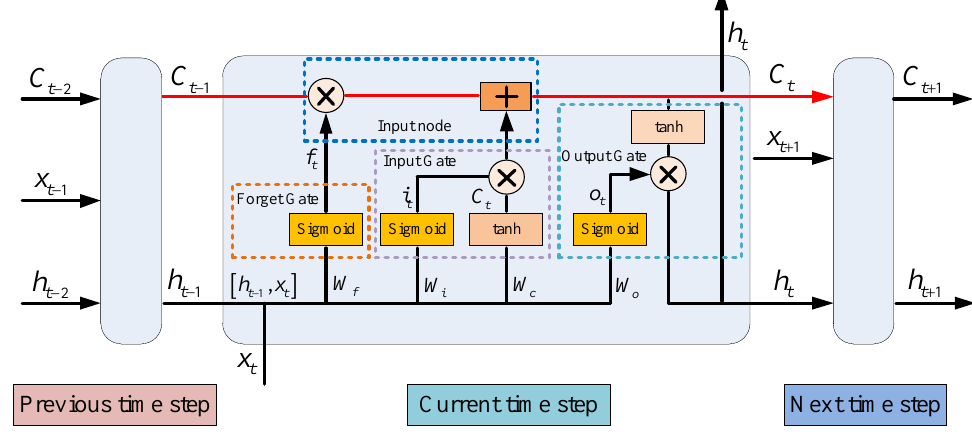
Figure 4. Basic LSTM architecture.